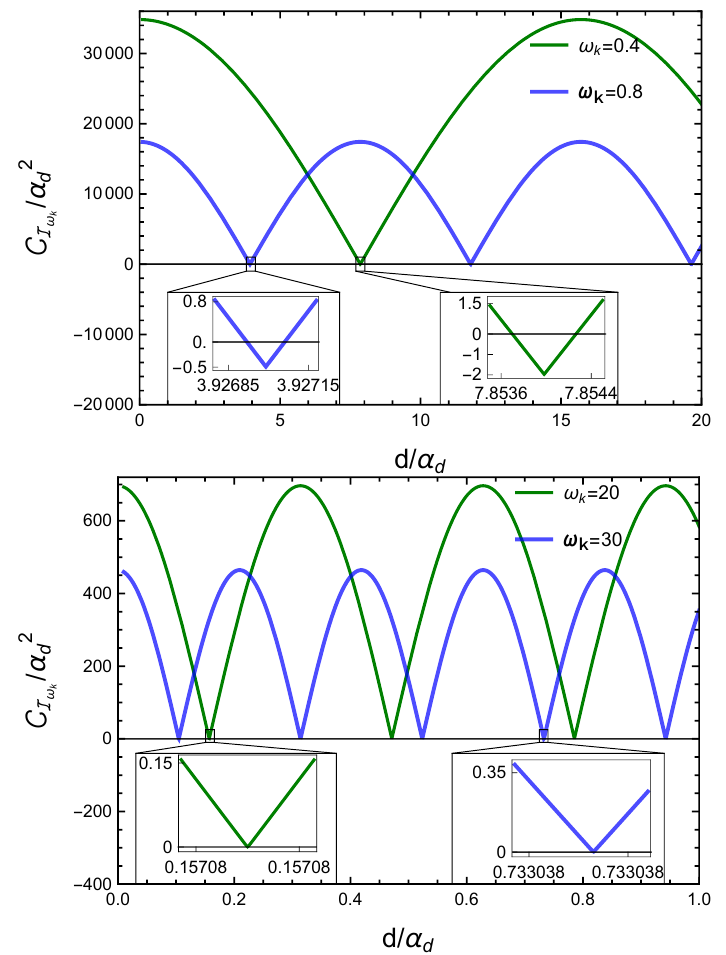
is plotted for two outgoing null detectors in different parallel Figure 25 . The quantity C I /α 2 d ωk paths in a (1 + 3) dimensional de-Sitter spacetime with respect to the separation between the two paths d/α . The frequency of the field are fixed at ω = 0 . 4 and ω = 0 . 8 , respectively in the upper d k k plot (showing very small shadow regions) and ω = 20 and ω = 30 , respectively in the lower plot k k (showing shadow points). Here we fixed k = ω 2 , and ∆ E = 0 . 5 x k /